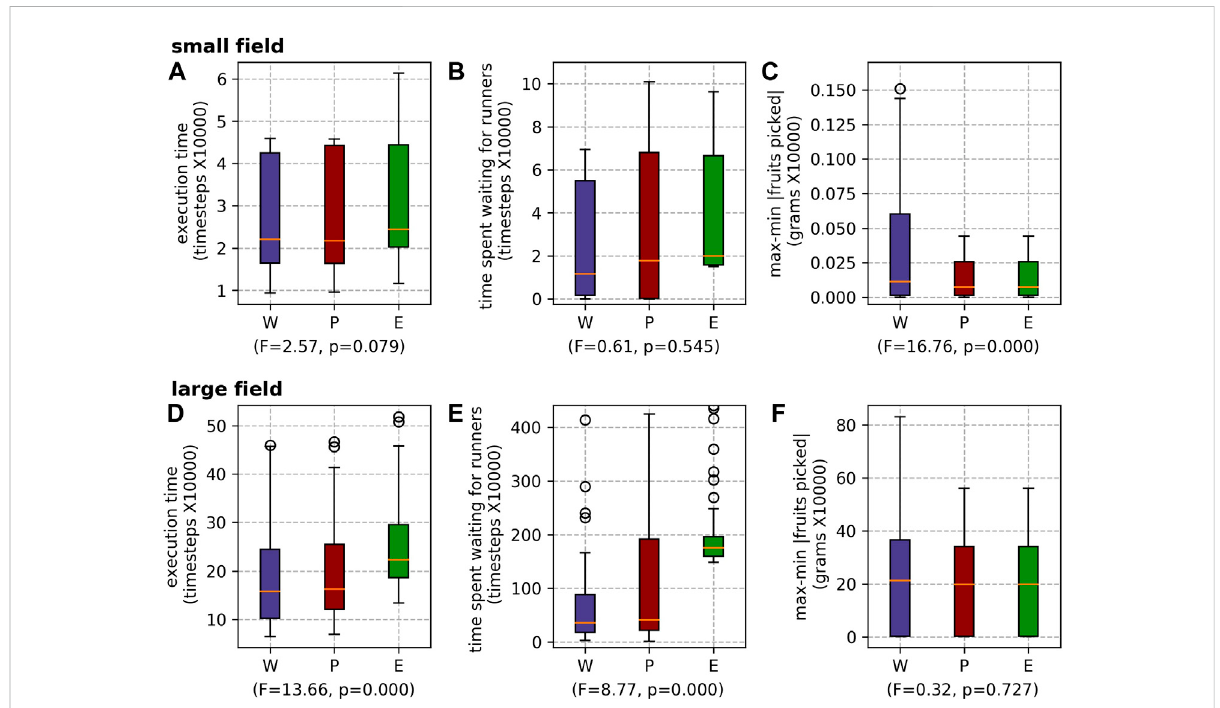
FIGURE 13 Results for the different runner scheduling modes for both farms: the small fi eld (A) execution time, (B) waiting time and (C) max-min |fruits picked|; and the large fi eld (D) execution time, (E) waiting time and (F) max-min |fruits